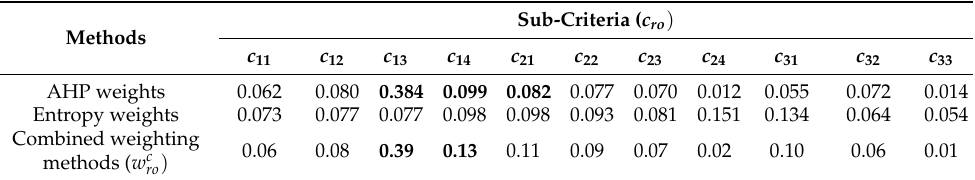
Table 16. The combined weighting methods ( w c ro ) . Methods